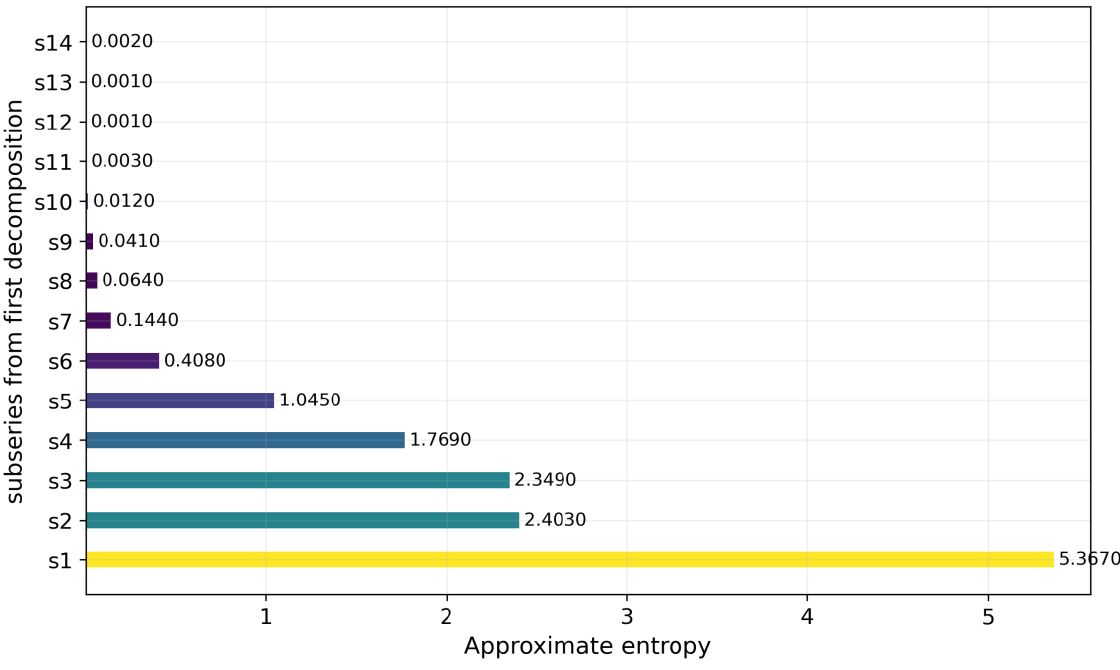
Figure 11. CEEMDAN and AE calculation.